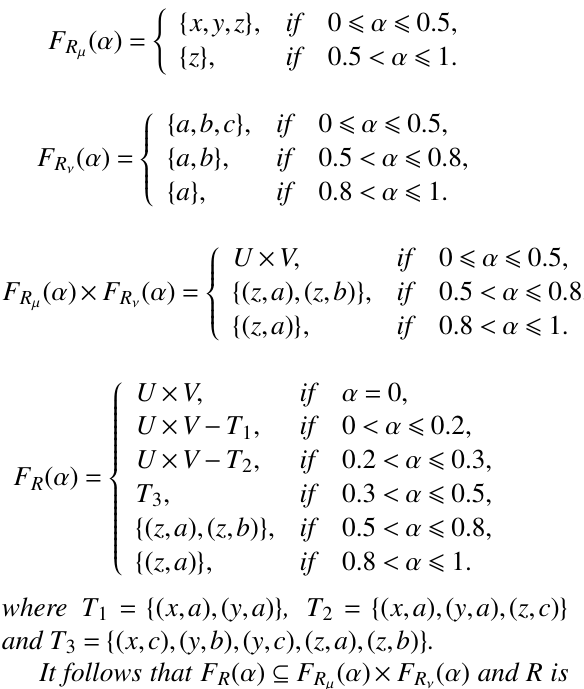
Table 3. Soft set related to